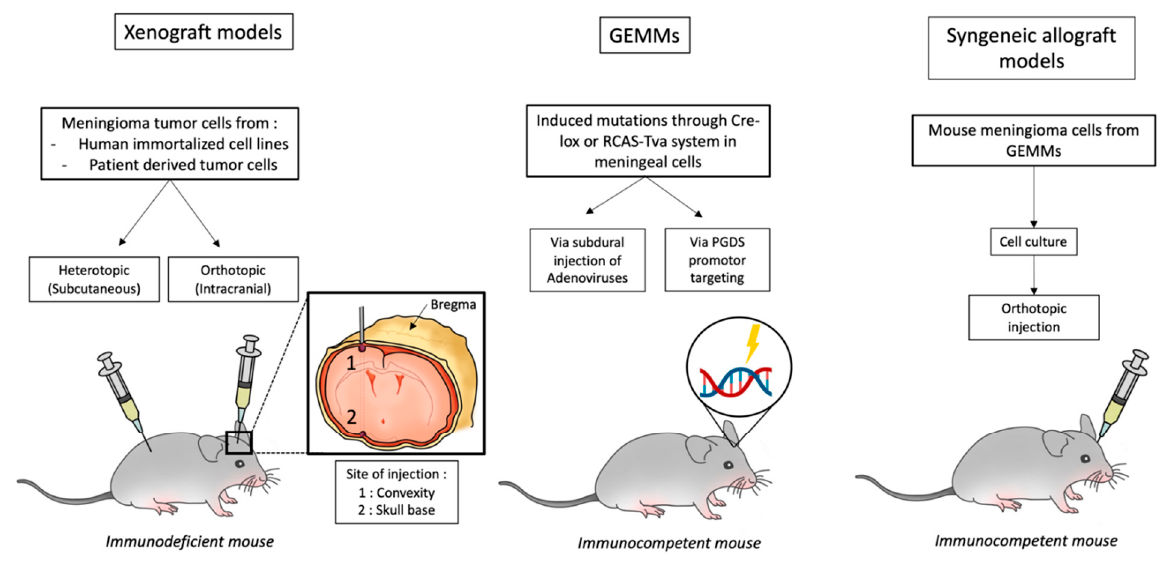
Figure 1. Illustration of different available mouse models of